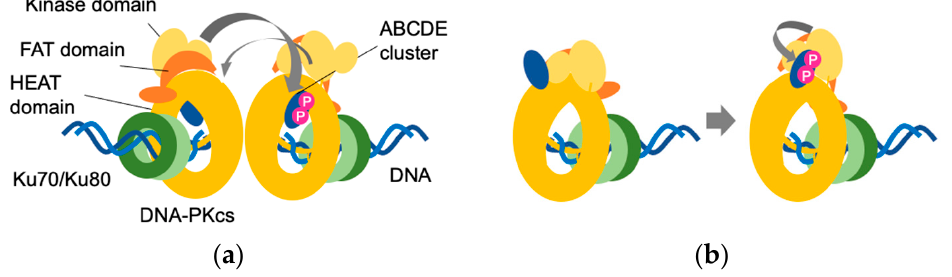
Figure 3. Schematic representation of a putative ABCDE cluster. ( a ) A putative ABCDE cluster is located inside the HEAT domain. Autophosphorylation occurs in trans; ( b ) Another putative ABCDE cluster is located outside the HEAT domain. Autophosphorylation occurs in cis. A blue oval indicates the ABCDE domain; a P in white on a pink circle indicates the phosphate group.